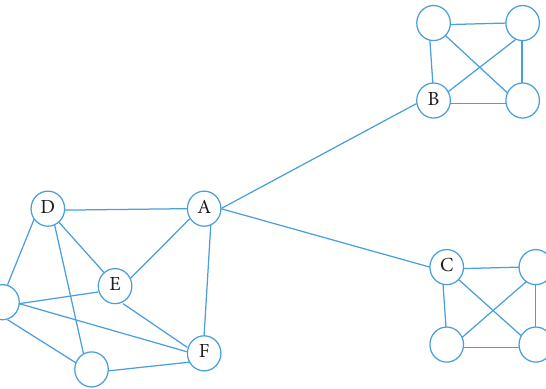
Figure 3: Schematic diagram of weak connection